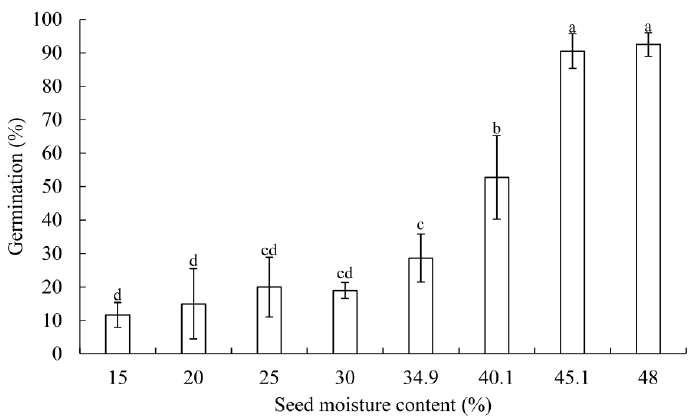
Figure 2. Changes to moisture content (MC) in G. biloba seeds during desiccation.